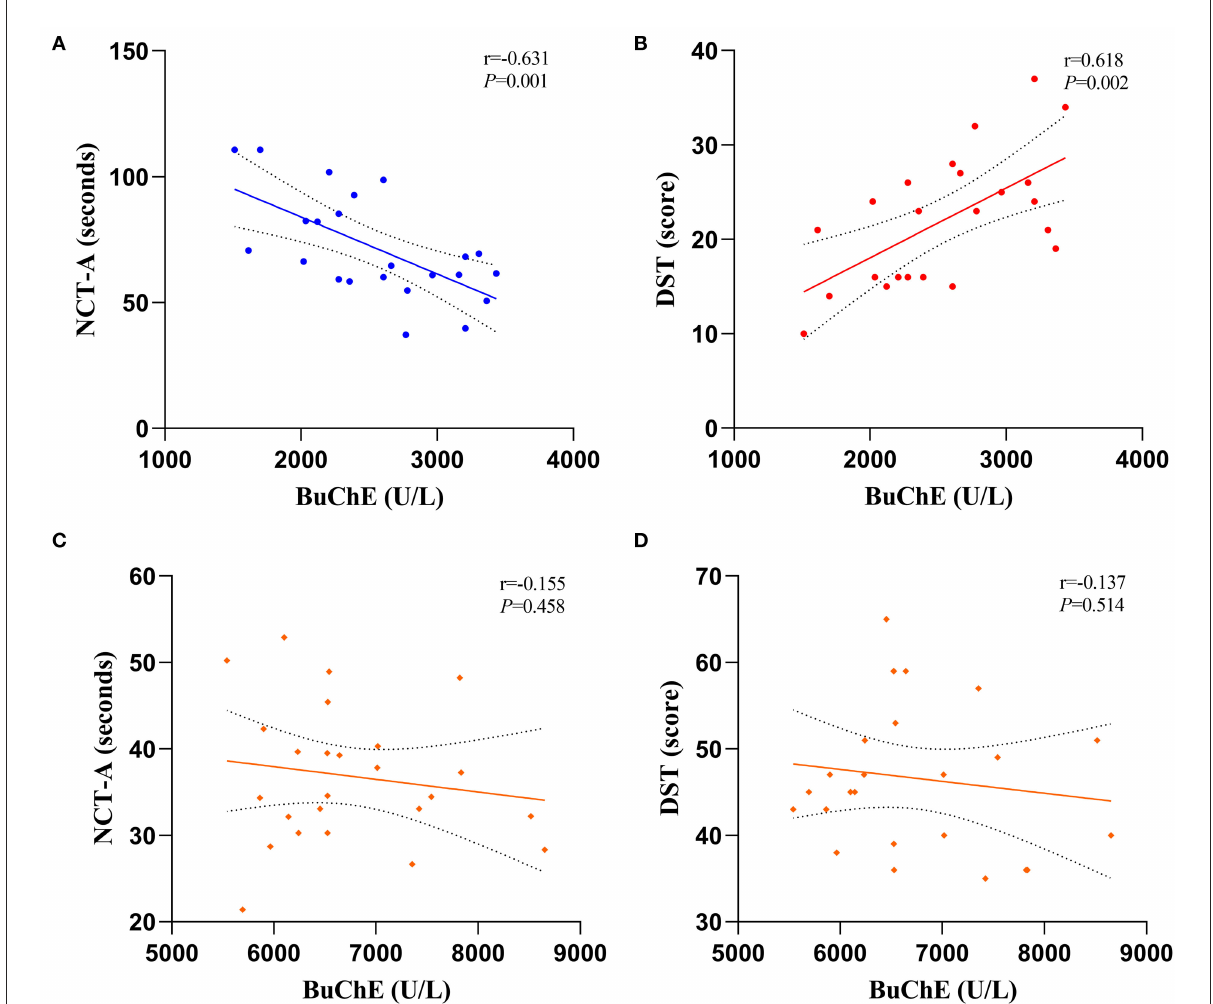
FIGURE2 Correlations between BuChE activity with NCT-A and DST scale scores, (A,B) are MHE groups and (C,D) are HC